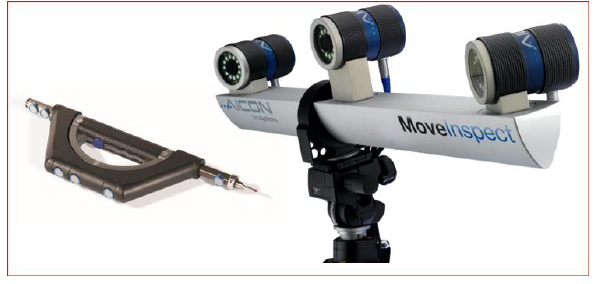
Figure 10: 3-camera system with handheld